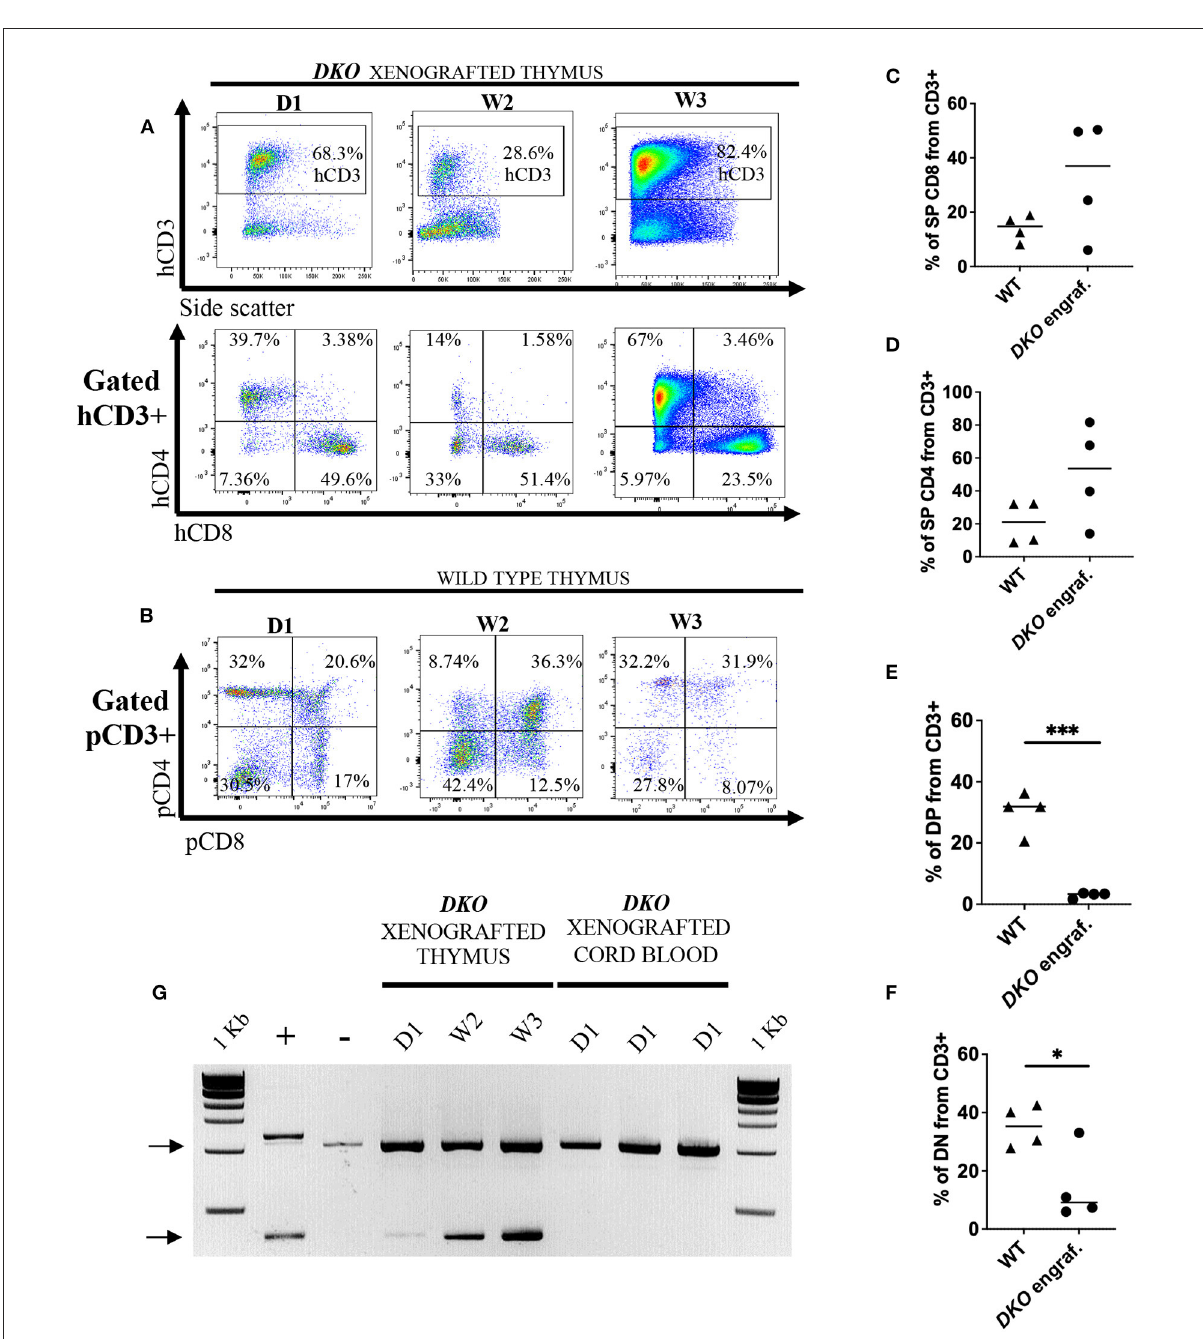
FIGURE9 Sustained human engraftment of the thymus in DKO xenografted pigs. (A) Flow cytometry analysis from xenografted DKO pig thymi for hCD3, hCD4 and hCD8 from birth to 3 weeks of age. In contrast to peripheral blood and spleen, where human cells were undetectable by 2 weeks of age, in the thymus, robust engraftment could still be detected at 3 weeks of age. There were no changes in the distribution of SP hCD4, SP hCD8 with age. (B) Flow cytometry plots of wild-type pig thymi showing pig CD4 and pig CD8 expression in age-matched wild-type pig thymi. (C–F) Scatter plot with individual values for percentages (from CD3 + ) of pig (WT) and human (xenografted) CD3 + CD8 + (C) , CD3 + CD4 + (D) , DP (E) and DN (F) from wild type and xenografted thymi, respectively. Line represents the mean, and adjusted p values are represented for unpaired two-sample t-test with a significance value of 0.05. (G) PCR assay with human primers specific for identification of human TREC ( ∼ 400 bp). Pig IL2RG amplicon served as internal primer control ( ∼ 1Kb) (Top black arrow). Each PCR reaction contains 50 ng of gDNA. Human peripheral blood mobilized stem cells gDNA served as positive control ( + ), while gDNA from the thymus of a non-injected DKO pig served as negative control (–). Samples tested include thymus from xenografted pigs (birth, 2 weeks, and 3 weeks), and gDNA from cord blood of xenografted DKO pigs at birth (when human cells were detected via flow